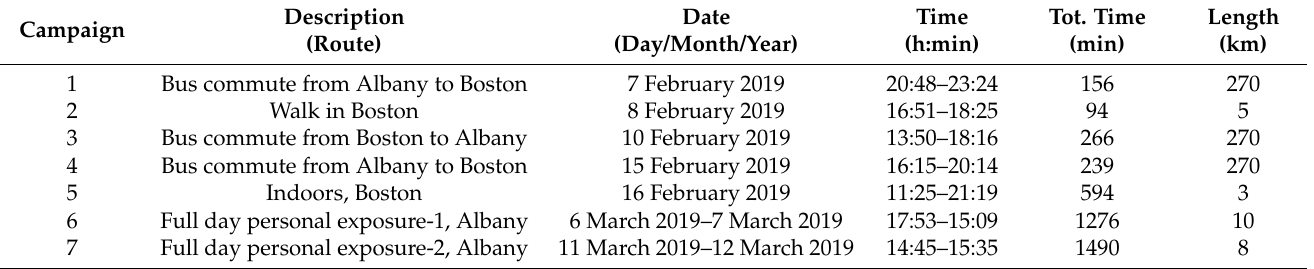
Table 1. Description of the sampling campaigns.